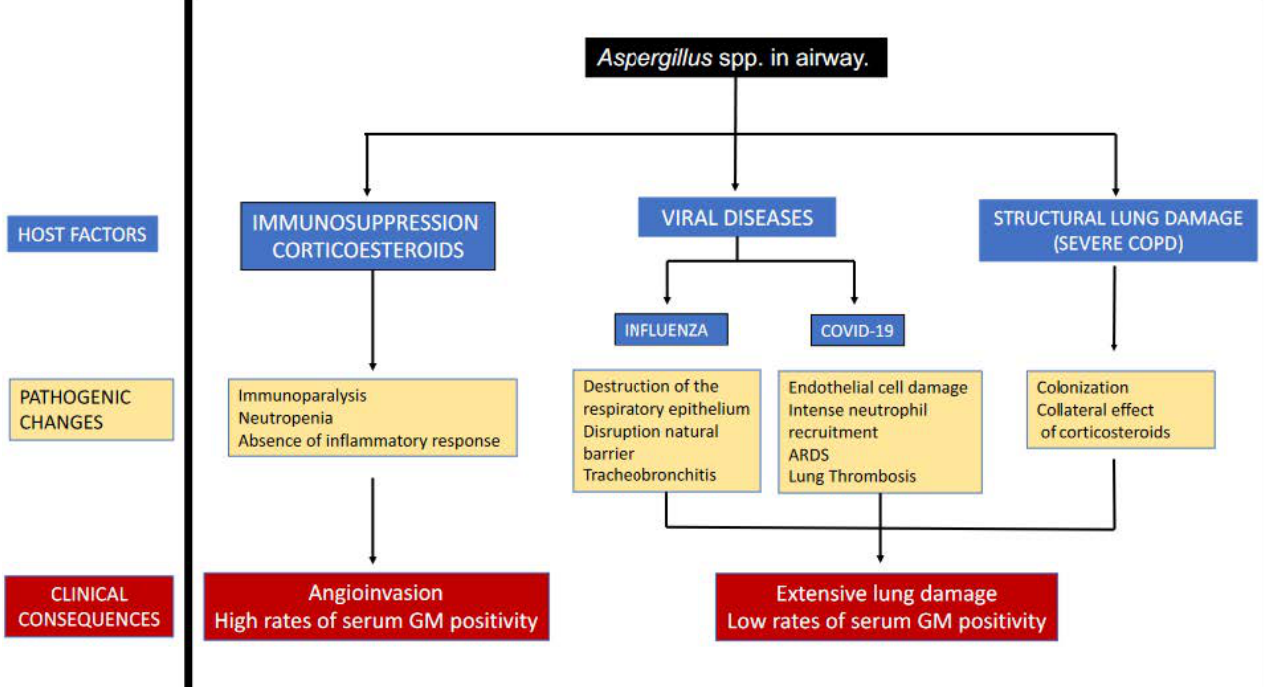
Figure 1. Pathophysiology and clinical consequences of IPA depending on host factors. Abbrevia- tions: COPD: Chronic obstructive pulmonary disease, ARDS. Acute respiratory distress syndrome, GM: Galactomannan.